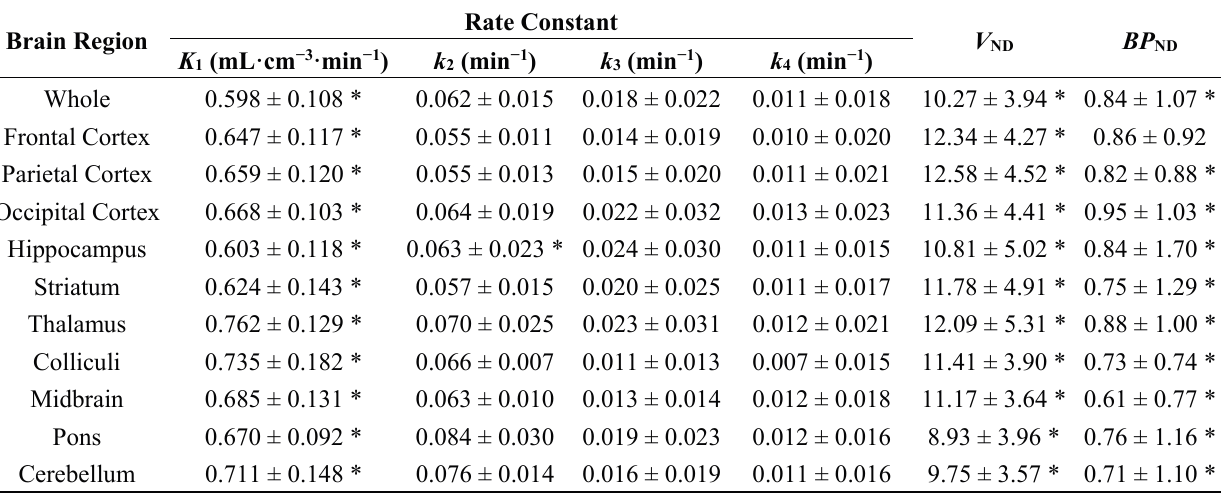
Table 4. Kinetic rate constants, non-displaceable volume of distribution ( V ND ), and non-displaceable binding potential ( BP ND ) of [ 18 F] 10a in different regions of piglet brain using 240 min of scan data under blocking conditions ( n =